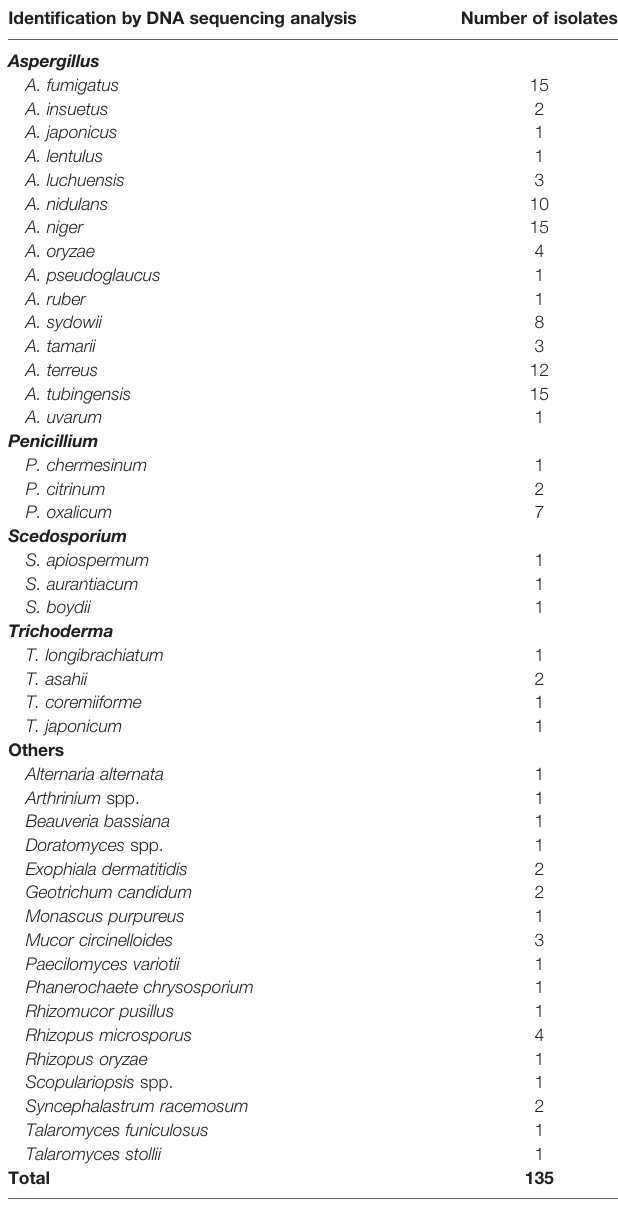
TABLE 2 | List of isolates included in the in-house library of M-Discover 100